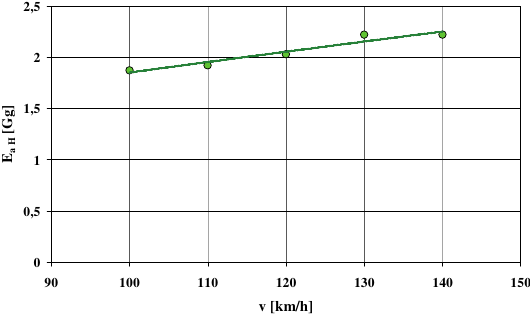
Fig. 6. Dependence of the national annual emission of volatile organic compounds from passenger cars upon the average velocity, under model conditions of traffic on highways and expressways